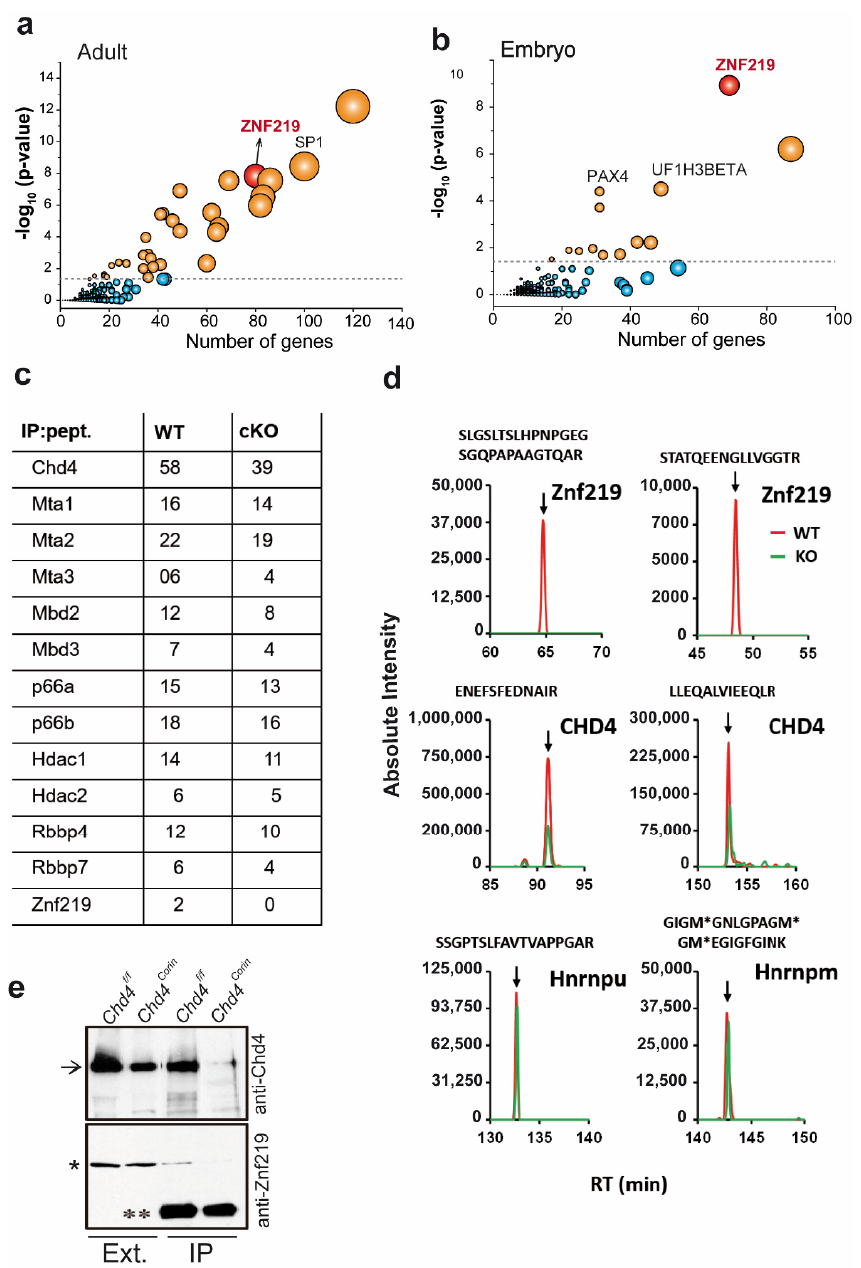
Figure 1. Chd4 and Znf219 physically interact in the mouse heart. ( a ) Bubble plot representation of the enrichment analysis for transcription factor (TF) binding sites in the set of upregulated genes in adult Chd4 corin hearts (TRANSFAC version 7.4). ( b ) Bubble plot representation of similar enrichment analysis for TF binding sites present in the set of upregulated genes in ED10.5 Chd4 nkx hearts. ( c ) The Chd4/NuRD complex composition in heart tissue; components were identified from peptides (pept.) recovered by mass spectrometry after Chd4 immunoprecipitation (IP) from 4-week-old WT mouse hearts ( Chd4 F/F ; Corin wt/w ). The table represents the number of distinct peptides (IP: pept.) derived from the proteins associated with Chd4 (Mi-2 β ) in WT hearts, and in Chd4 corin ( Chd4 F/F ; Corin cre/cre ) cKO hearts. ( d ) The specificity of the association of Znf219 with WT Chd4 was demonstrated by analyzing the extracted ion chromatography traces of the peptides from the proteins indicated in each graph. M* means oxidated methionine. ( e ) Western blot of WT and Chd4 corin cardiac nuclear extracts (Ext.) and Chd4 ( α -Chd4) immunoprecipitated (IP), showing an association between Chd4 (arrow) and Znf219 (*)) only in WT hearts; ** = IgG heavy chain from denaturalized IP antibody. The double asterisk marks the heavy chain of antibodies used for